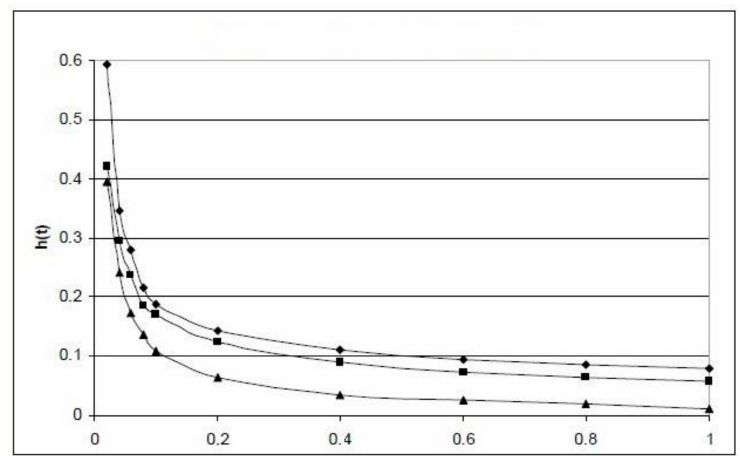
Figure 1. The form of the pseudo-Green function h ( t ) of the Caputo DOFD for different values of the couple ( c , d ) c = 0.8 ; d = 0.9 (triangles), c = 0.45; d = 0.55 (squares), c = 0.1; d = 0.2